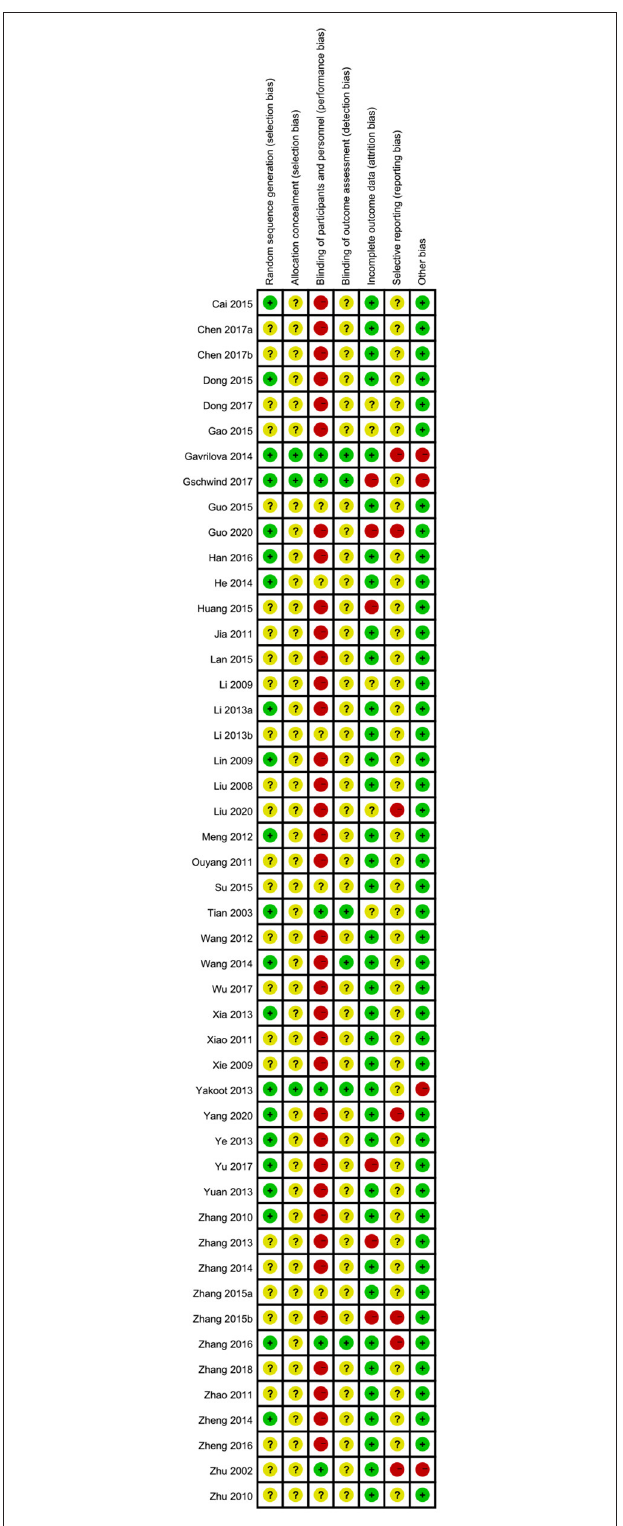
FIGURE 3 | Risk of bias summary: review authors’ judgments about each risk of bias item for each included